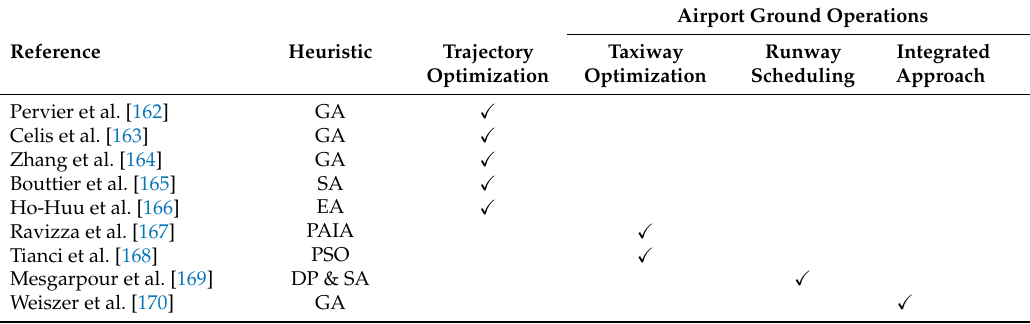
Table 7. Relevant literature in energy-related air transportation optimization based on the employed heuristic method (GA, Genetic Algorithm; SA, Simulated Annealing; EA, Evolutionary Algorithm; PAIA, population adaptive immune algorithm; PSO, Particle Swarm Optimization; DP, Dynamic Programming) and the strategy